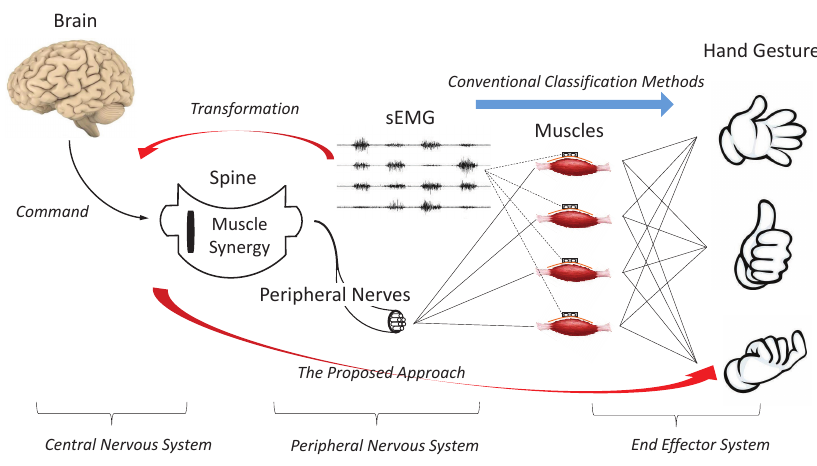
Figure 1. Human hierarchical system for controlling hand gestures.